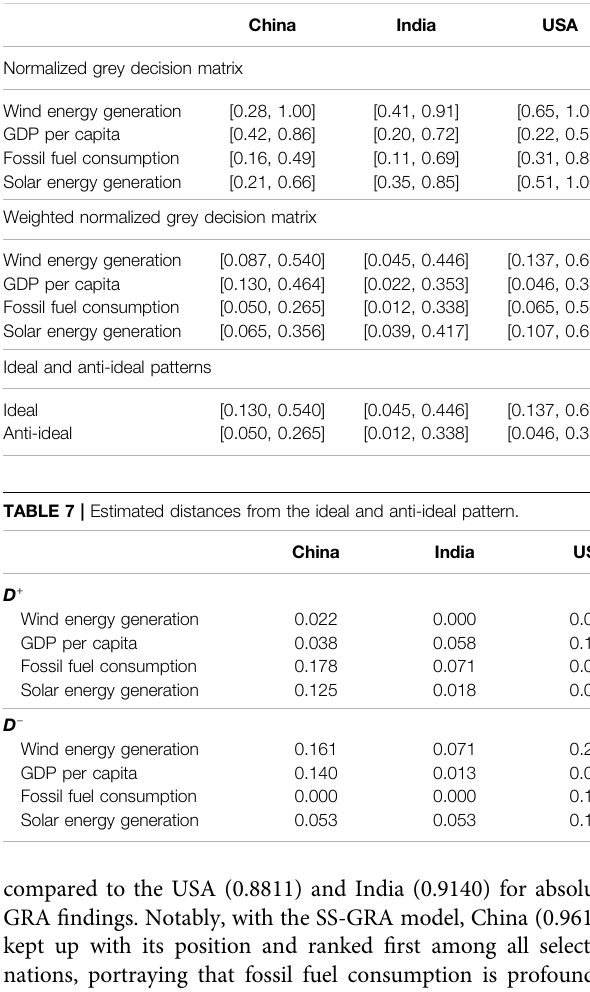
TABLE 6 | Formation of a grey decision matrix to identify the potential factor.